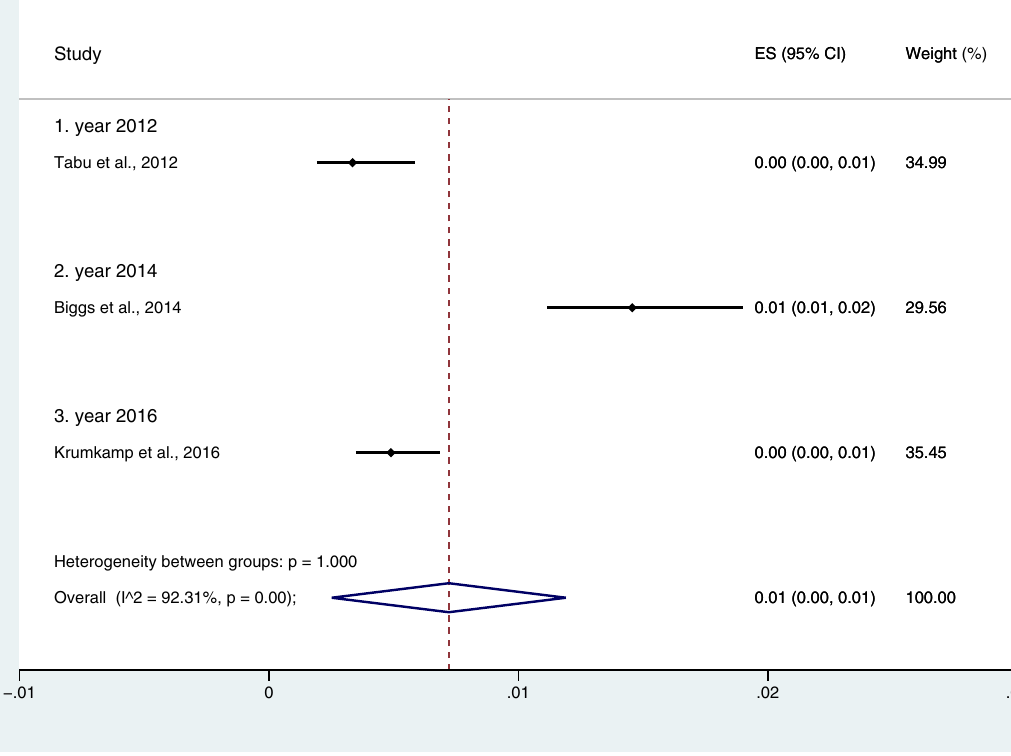
Figure 10. Pooled prevalence of NTS and malaria co-infection using blood cultures for the identification of Salmonella spp. infection stratified by time (publication year). ES proportion estimate (multiply 100 units for interpreted as prevalence estimate), CI confidence interval, NS not